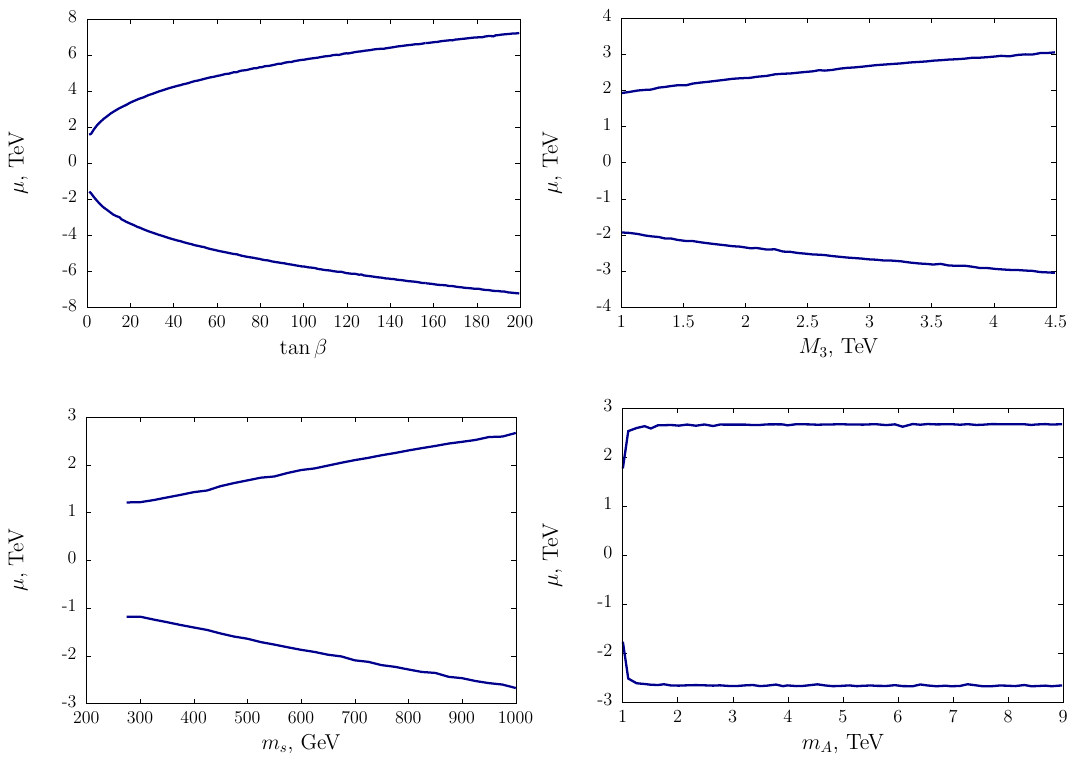
Figure 5. Slices of the conditional boundary Br ( s hh ) = 0 : 125 between gluon dominated and ! massive boson dominated regimes of sgoldstino decay on the planes (tan (cid:12); (cid:22) ) (upper left panel), ( M 3 ; (cid:22) ) (upper right panel), ( m s ; (cid:22) ) (lower left panel) and ( m A ; (cid:22) ) (lower right panel). Regions between the lines on the plots correspond to the gluon dominated sgoldstino decay. Other model parameters are (cid:12)xed as tan (cid:12) = 10, m A = 5 TeV, m s = 1 TeV, M 3 = 3 TeV, M 1 = M 2 = 1 TeV, p F = 20 TeV. K-factor for gg channel is K d = 1 :